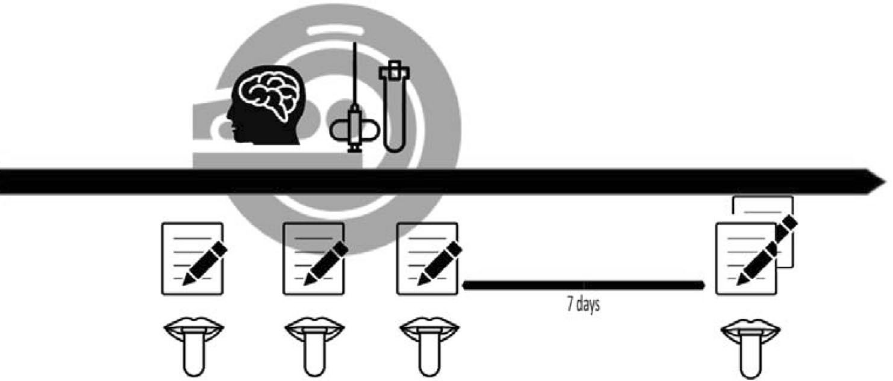
Figure 1. Schematic overview of the study design. The lower level timescale describes the days before and after biopsy, the upper figure describes the measurements taken during the biopsy